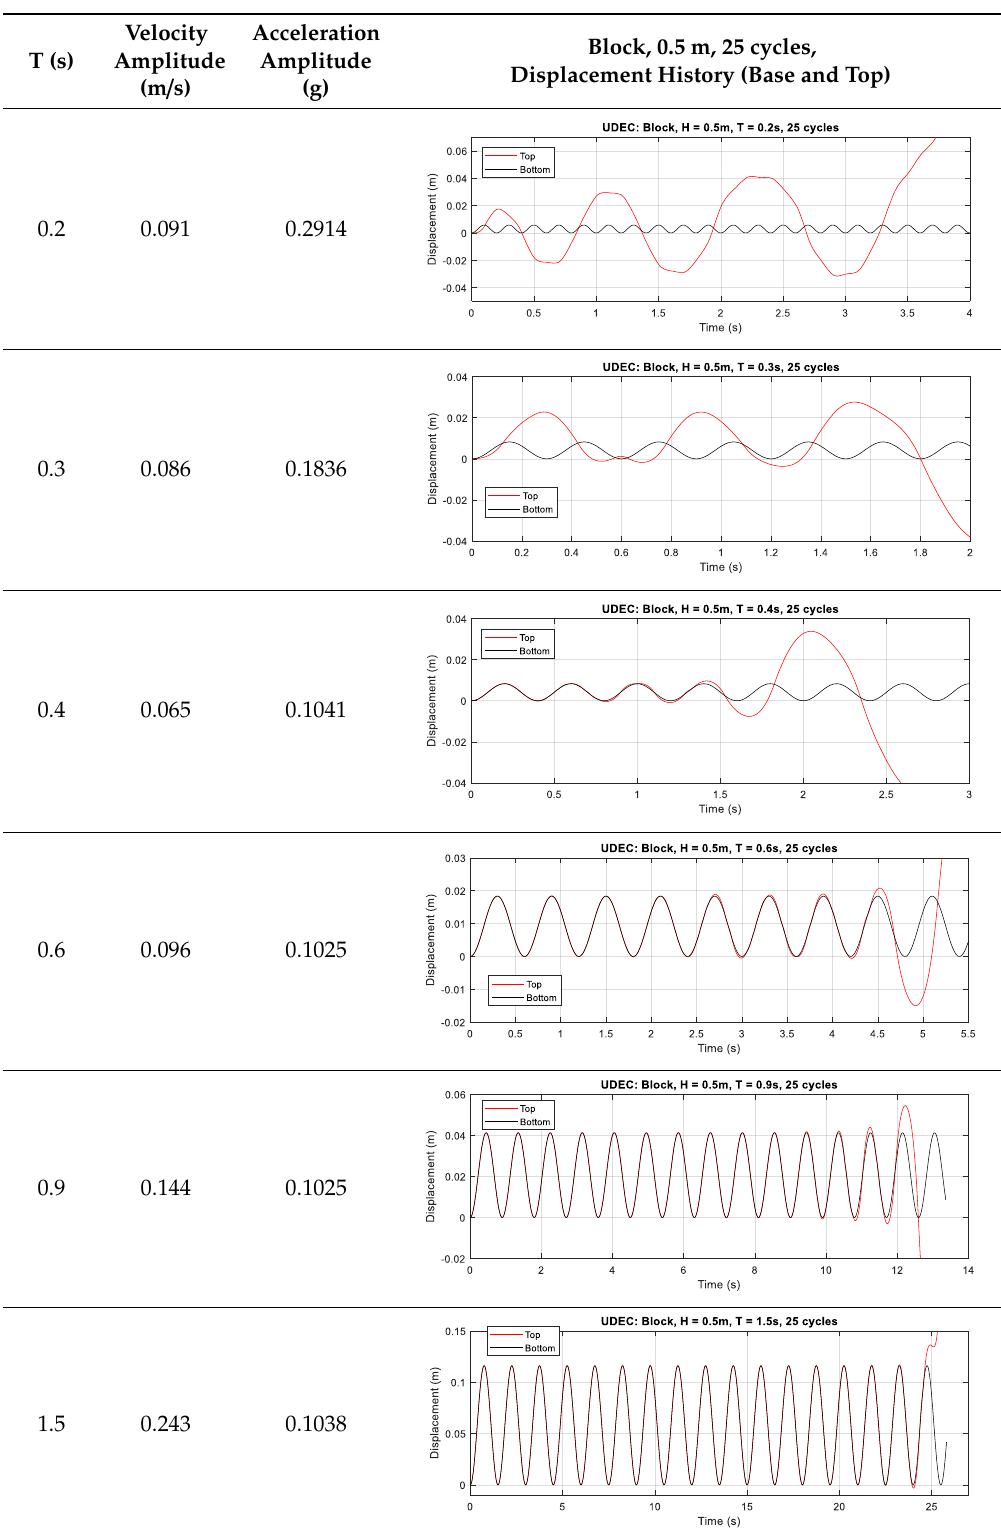
Table 1. Critical combinations for 0.5 m block UDEC simulation.